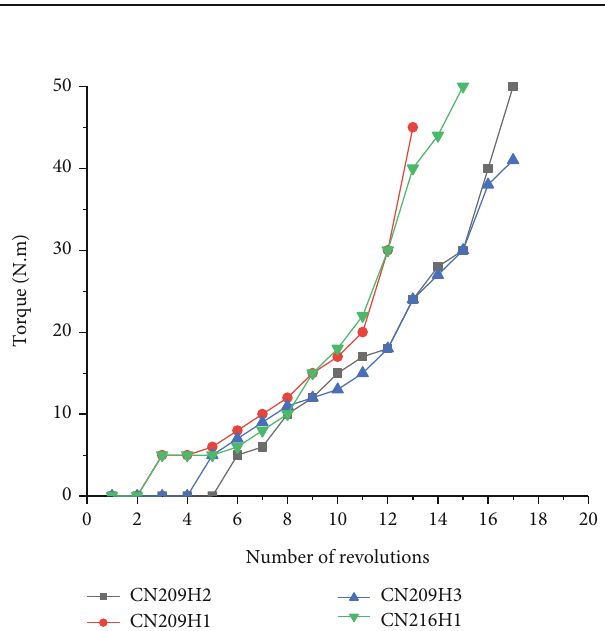
Figure 7: Evaluation results of fi eld drilling fl uid buckling